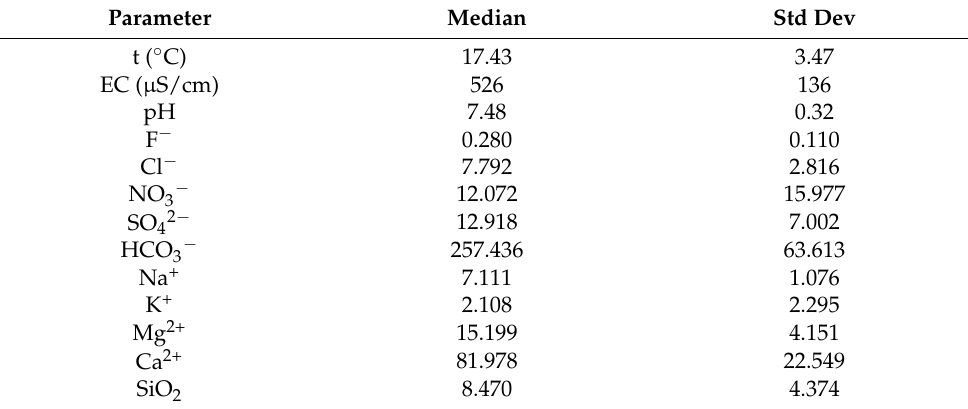
Table 1. Statistical summary with median value (Median) and standard deviation (Std dev) for each measured parameter for all of the 19 sampling points during the hydrological year. HCO 3 − were measured only in March, April, and